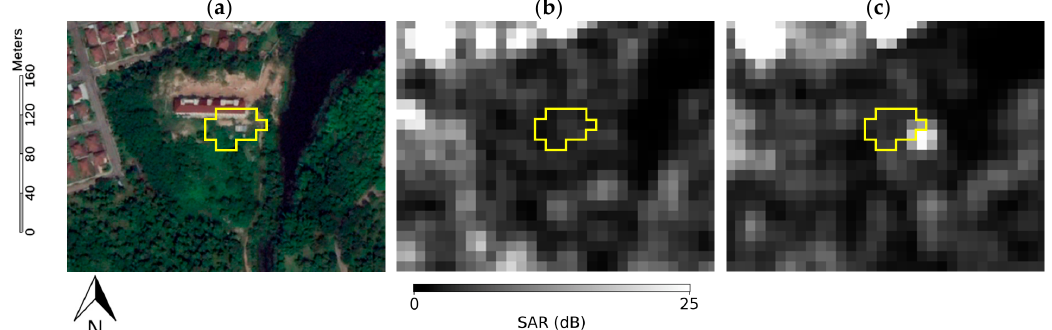
Figure 22. Detection results of CORN in the first area of Chiang Mai at 18°51’23.49”N 98°57’17.90”E in yellow hollowed polygon overlays on ( a ) a Time 2 optical images; ( b ) a Time 1 SAR image